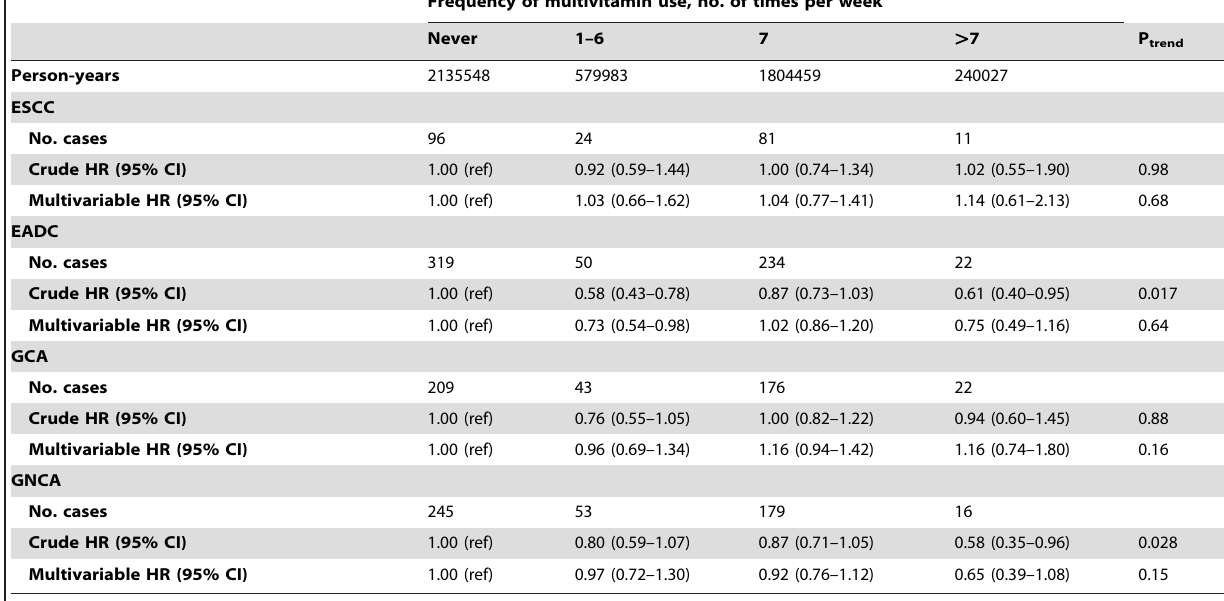
Table 2. Crude and adjusted* hazard ratios (HR) and 95% confidence intervals (CI) for use of multivitamin supplements for four upper gastrointestinal cancers in the NIH-AARP Diet and Health Study